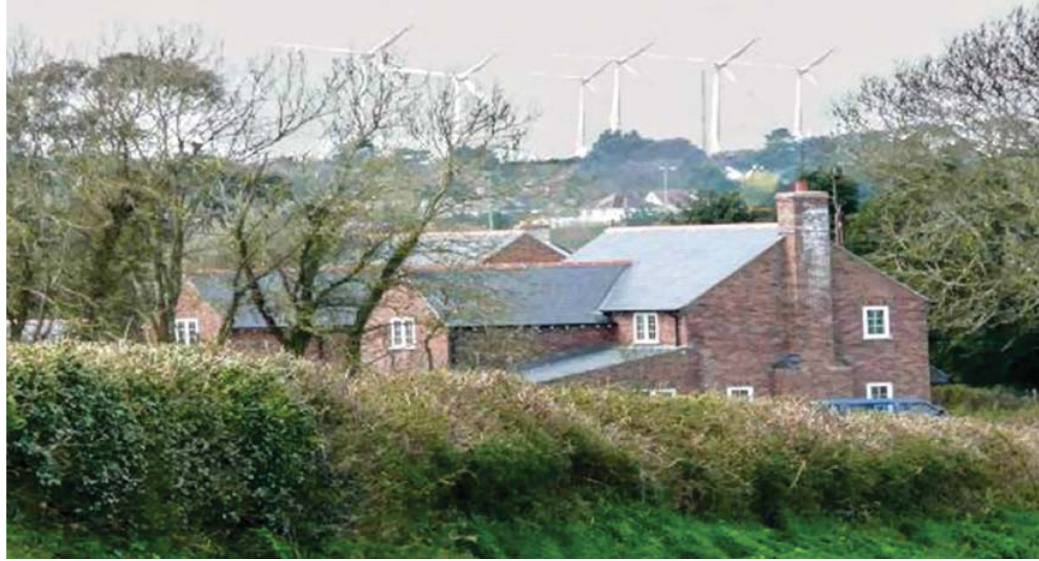
Figure 1. View of a wind farm from Nutcrack Lane, Dorset,